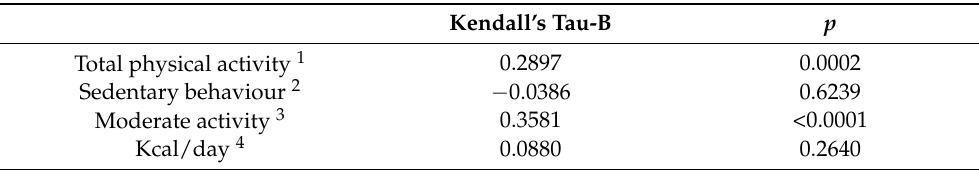
Table 7. Kendall’s tau-b coefficients between the tertiles objective and subjective method for measur- ing physical activity in the study population.